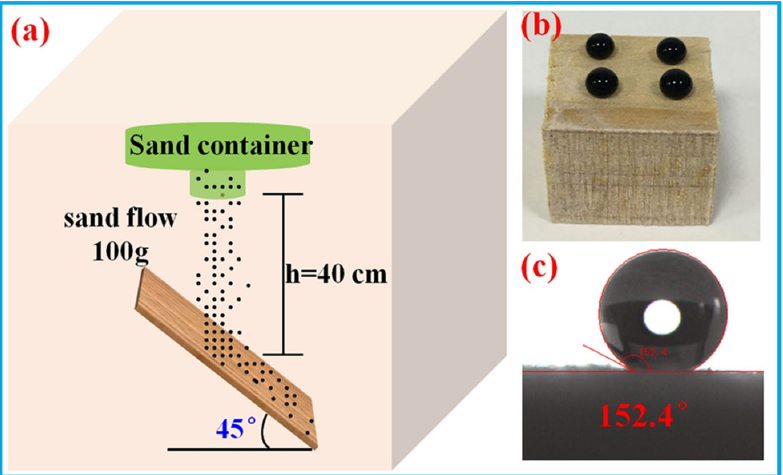
Figure 6. Schematic diagram of the falling sand impact abrasion tests ( a ); a water drop deposited on the as-prepared wood surface after sand abrasion ( b ) and the WCA test of wood surface after sand abrasion ( c